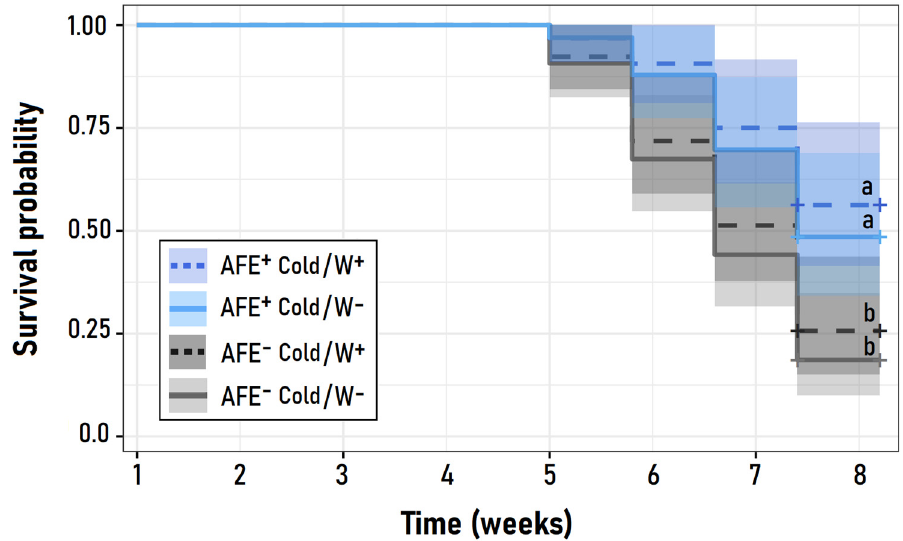
Table 2. Two-way analysis of variance (ANOVA) testing the effect of the presence/absence of two Antarctic fungal endophytes (AFE+ or AFE − ) and the stress condition (cold without water de fi cit [Cold/W+] or cold and water de fi cit [Cold/W − ]) on size (mm) and weight (g) of fruits blueberry plants ( Vaccinum corymbosum , cv Briggita). Significant factor effects ( p < 0.05) are highlighted in bold, d.f. : degrees of freedom; SS : sum of squares; MS : mean squares, F : F statistic; p : probability value.